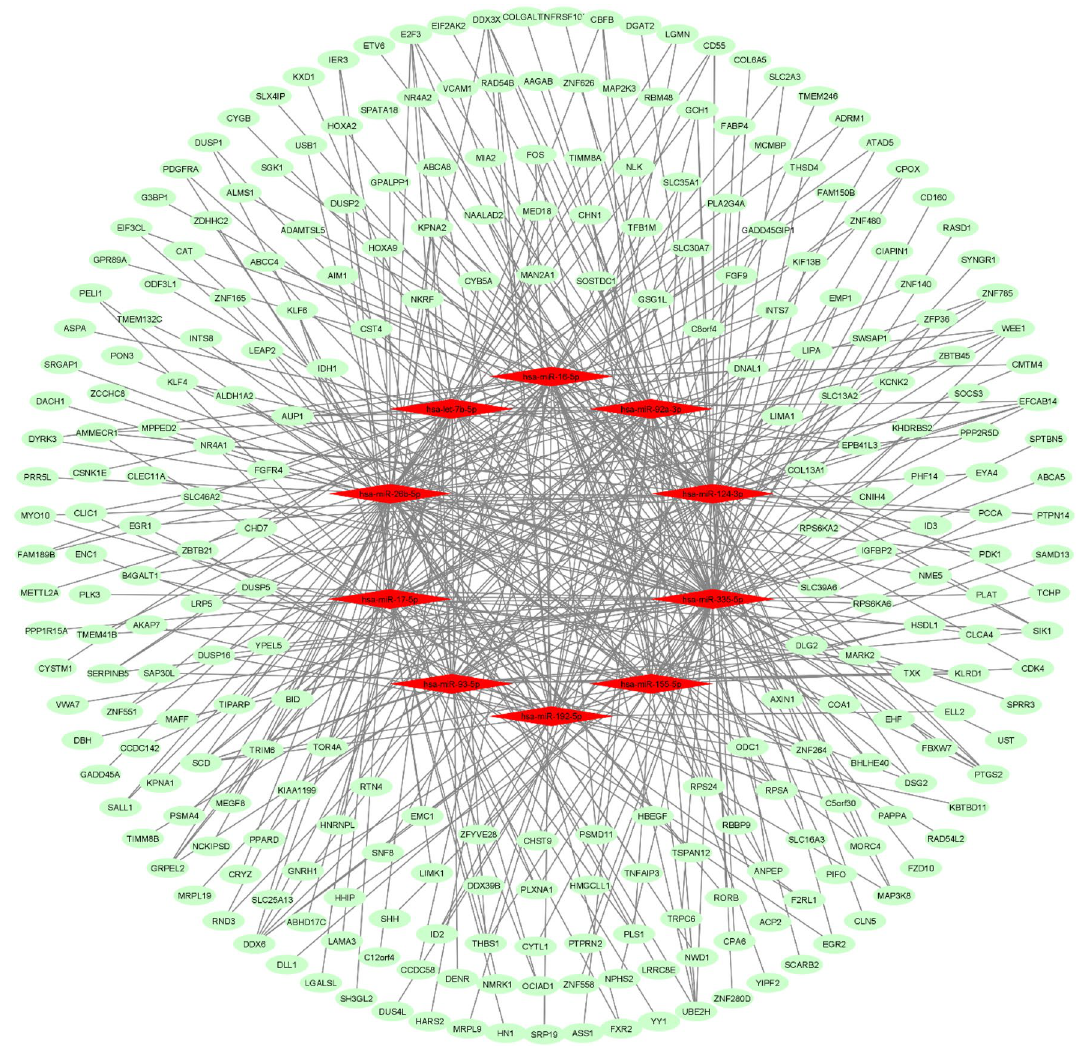
Figure 1. Bipartite mRNA-miRNA subnetwork for NBMSC-PBC. Cytoscape v.3.8.2 was used to visualize the